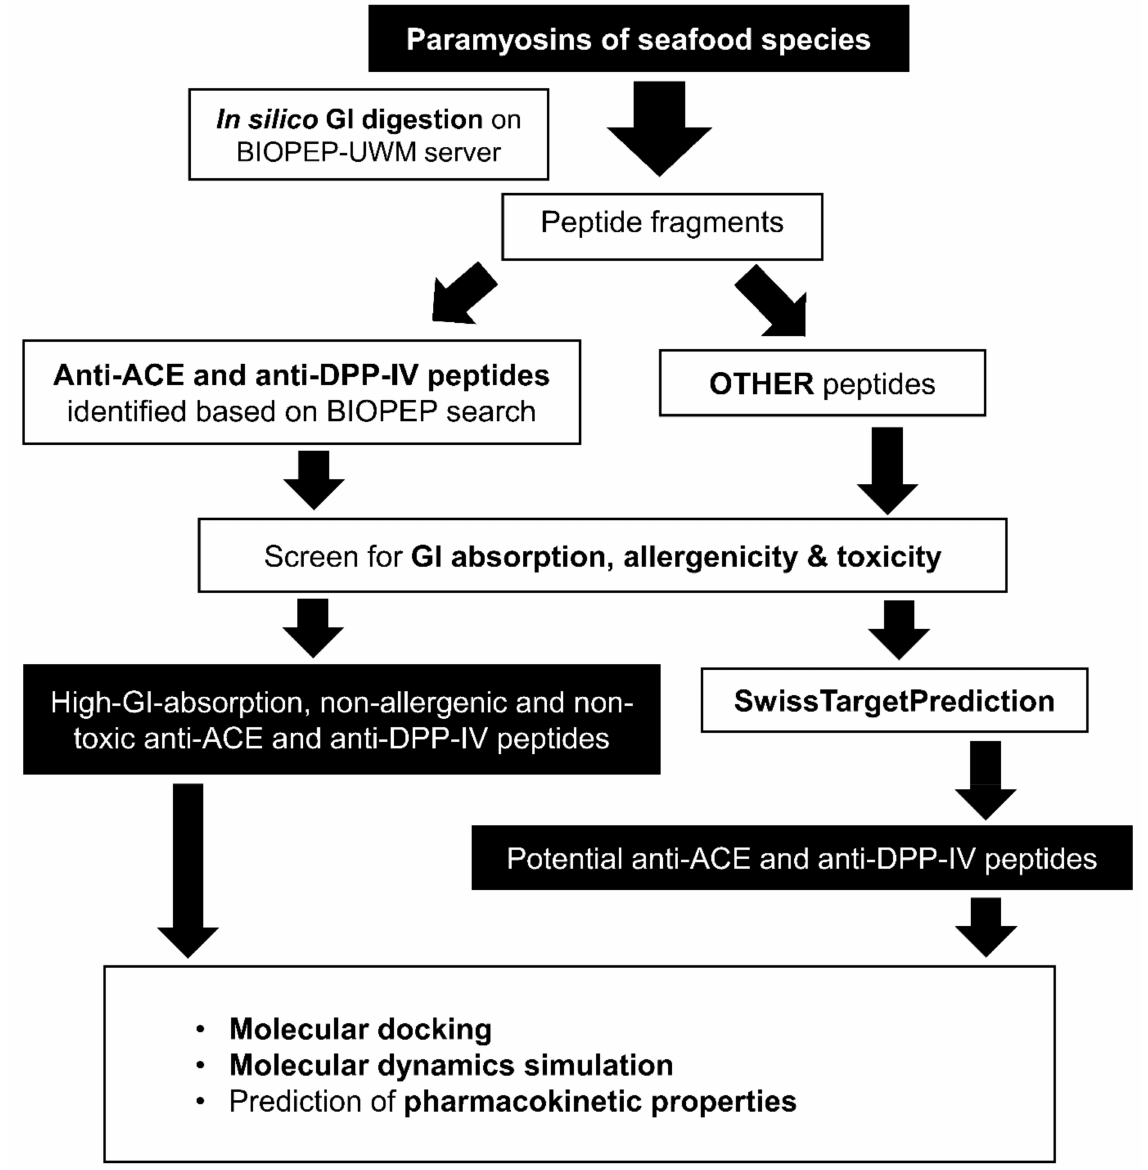
Figure 10. An overview of the